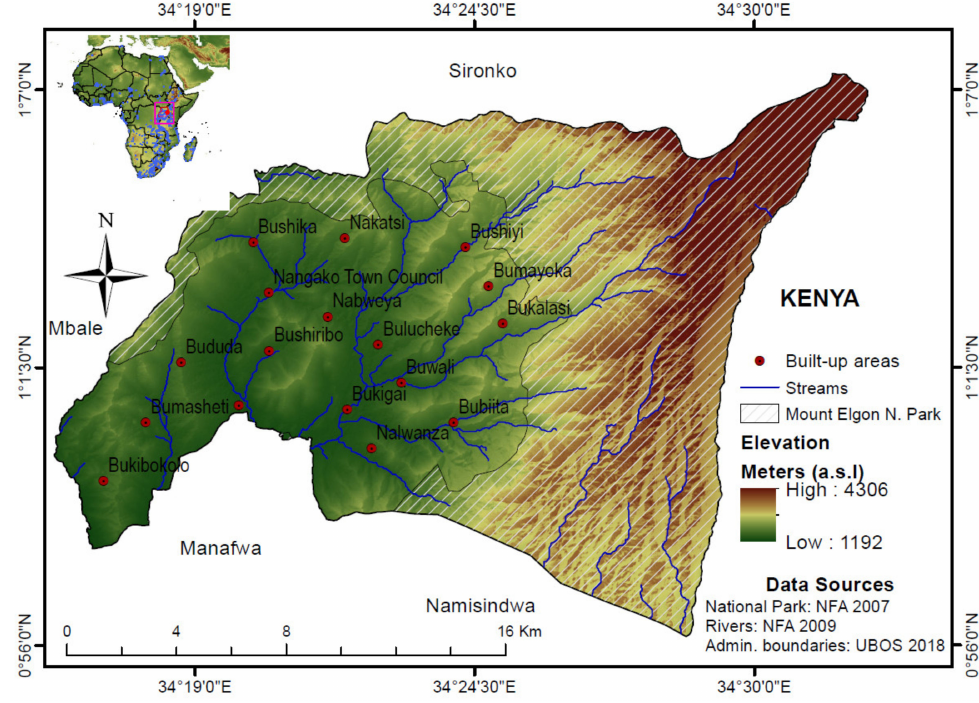
Figure 1. The location and extent of the upper Manafwa watershed with the elevation and drainage system, on Mount Elgon in Eastern